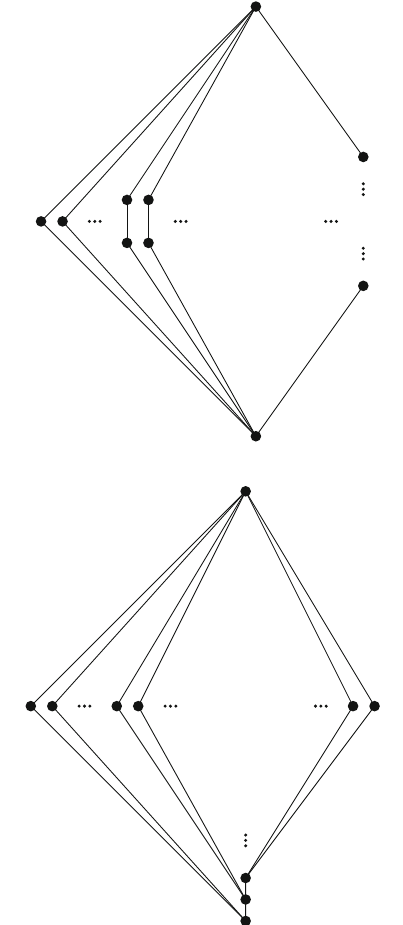
Fig. 4 Top: an artificially produced causal set whose purpose is to mimic both the height and width of our path length distribution. Bot- tom: a similarly produced artificial causal set which eliminates some redundancies to reduce the number of points while maintaining the